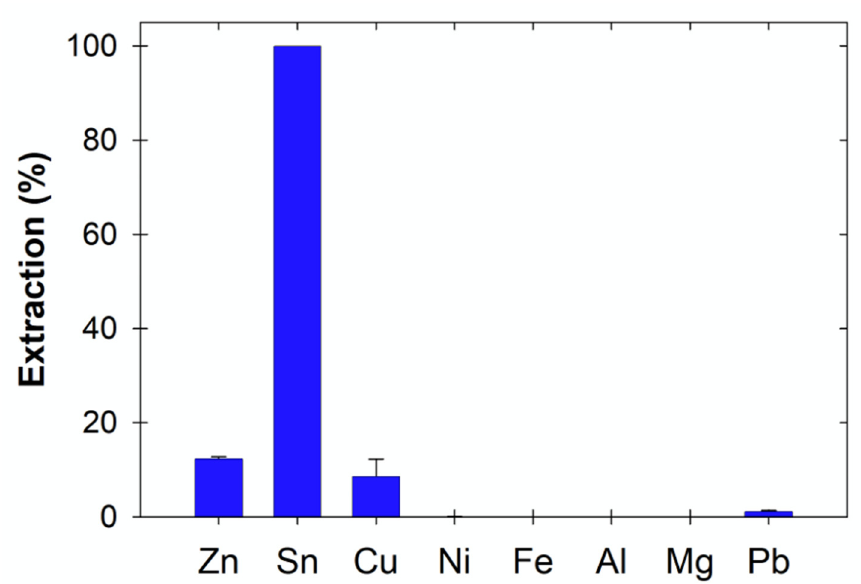
Figure 1. Extraction of metals from 1 × 1 cm 2 PCB pieces after 72 h in ChCl:EG without I 2 .